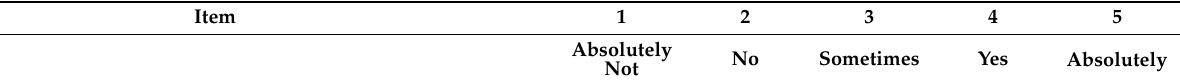
Table 1. The Latency Social-Psychological Developmental Questionnaire